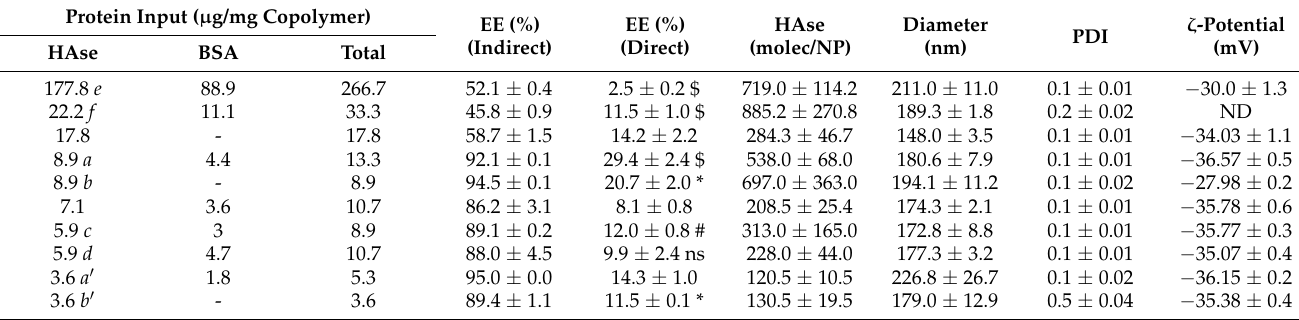
Table 2. Enzyme loading